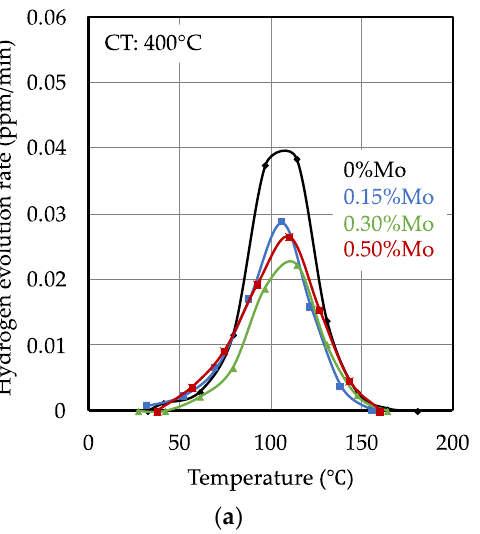
Figure 8. Thermal desorption spectra of bake hardened steels after 48 h of hydrogen charging in 10% ammonium thiocyanate solution. ( a ) Low coiling temperature (400 °C) and ( b ) high coiling temperature (600 °C).